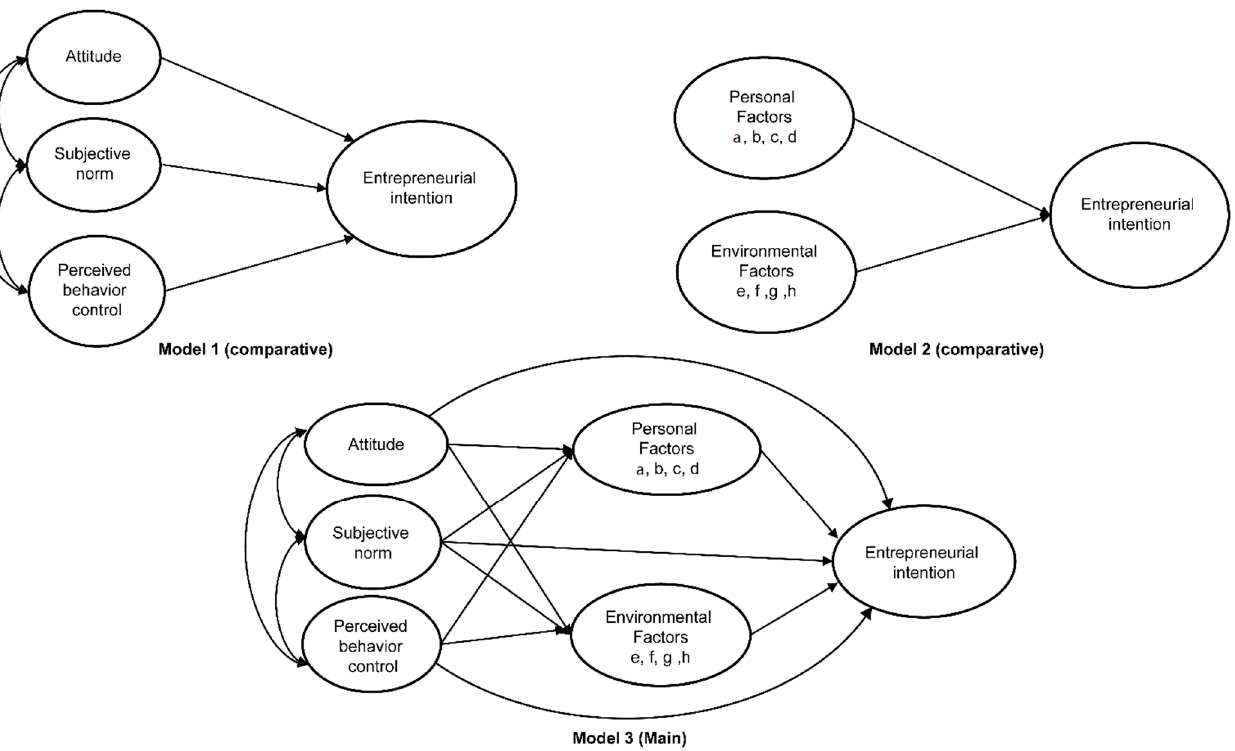
Figure 3. Hypothetical models of this study. (a) Self-efficacy. (b) Need for achievement. (c) Entre- preneurship. (d) Entrepreneurial orientation. (e) Social capital. (f) Funding. (g) Economic prepara- trepreneurship. ( d ) Entrepreneurial orientation. ( e ) Social capital. ( f ) Funding. ( g ) Economic tion. (h) Need for entrepreneurship education. preparation. ( h ) Need for entrepreneurship